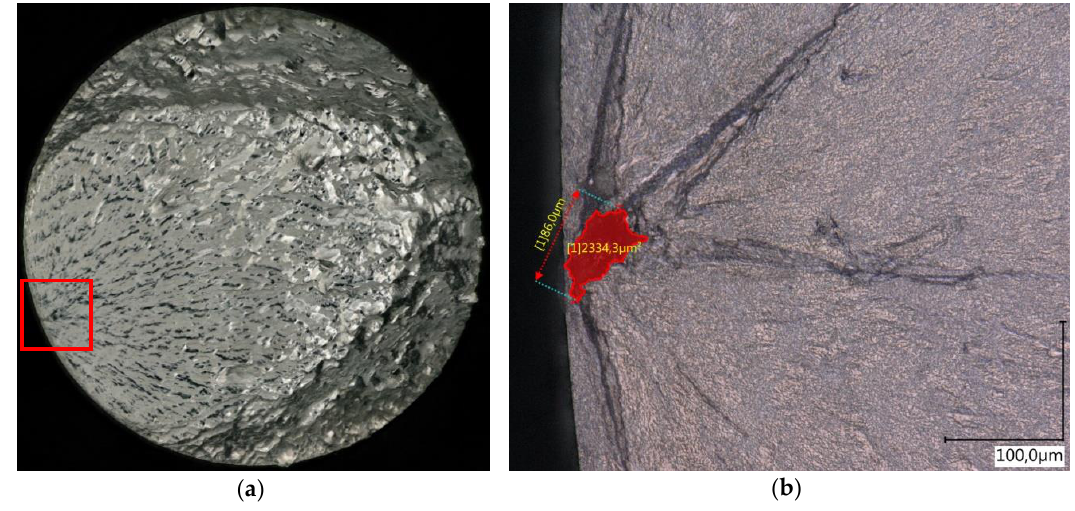
Figure 7. ( a ) Fracture surface of an as-built specimen; ( b ) size measurement of failure-critical defect.